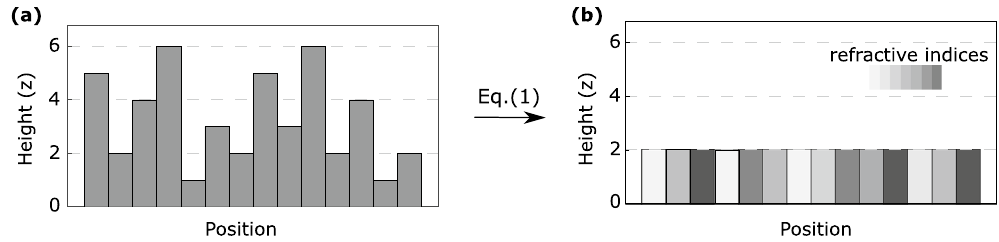
Figure 2. ( a ) An example of physical DOE having seven-step height levels. ( b ) An example of programmable DOE having seven refractive